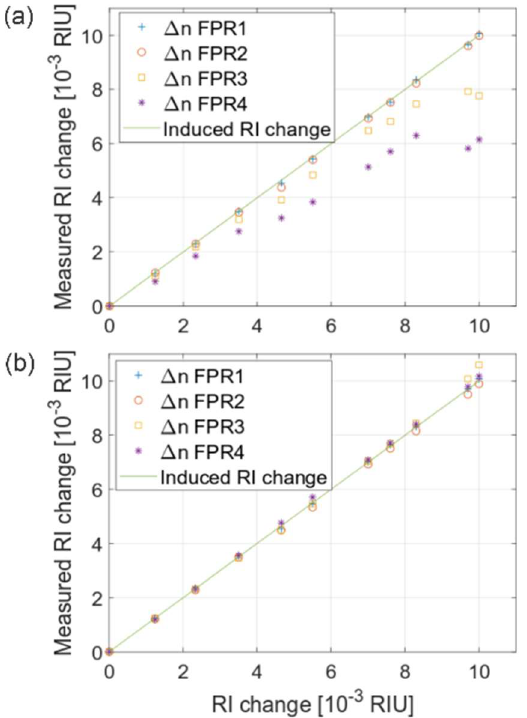
Fig. 4. Measurement of RI of the same liquid using the sensor from Fig. 1 (b) with four independent FP sensors with (a) uncoated FPRs) and (b) coated sensors FPR3 and FPR4.